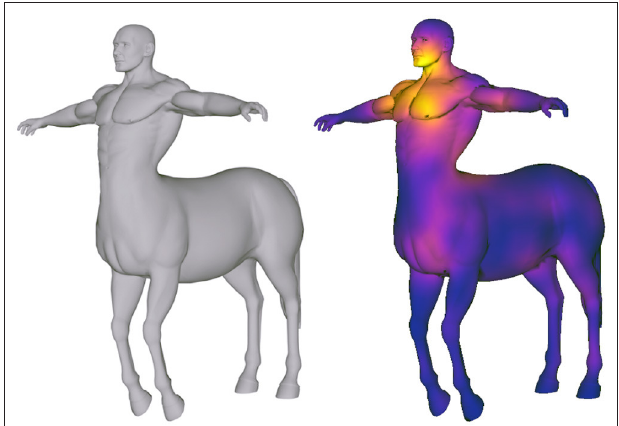
FIGURE 2 | Example of a 3D surface-based attentional map (or heat map). The centaur mesh is part of the TOSCA high-resolution dataset (Bronstein et al.,